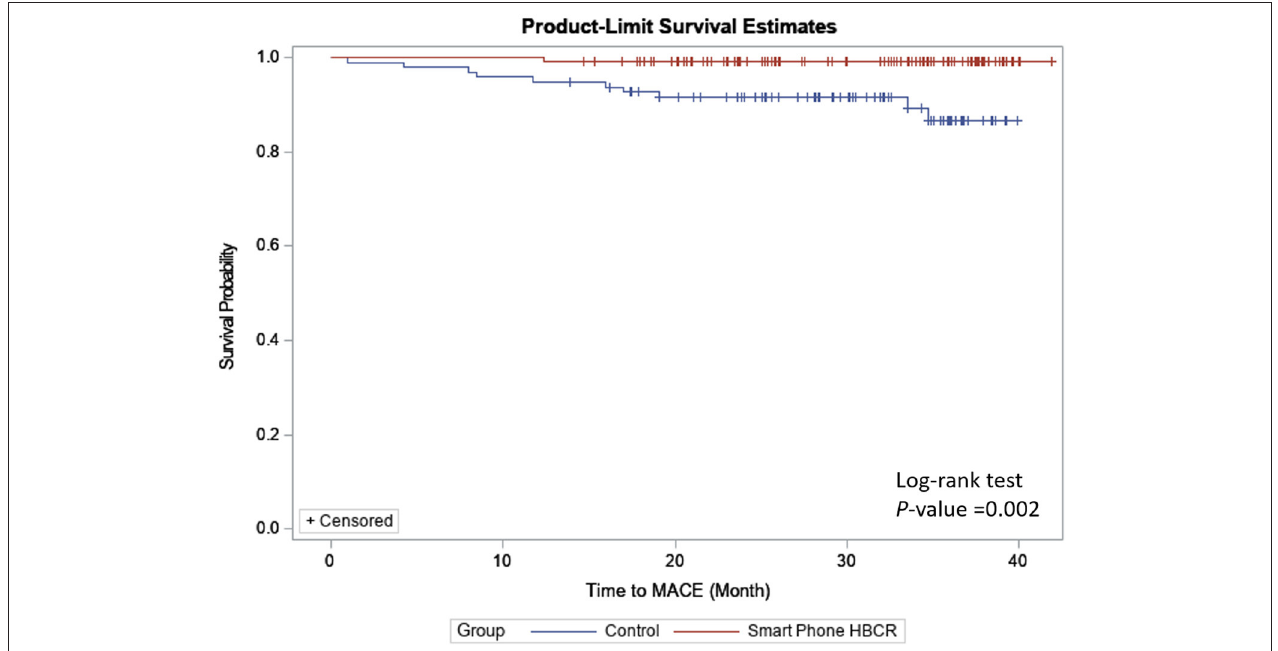
FIGURE 1 | Kaplan–Meier plot for MACE, stratified by intervention status (for the matched